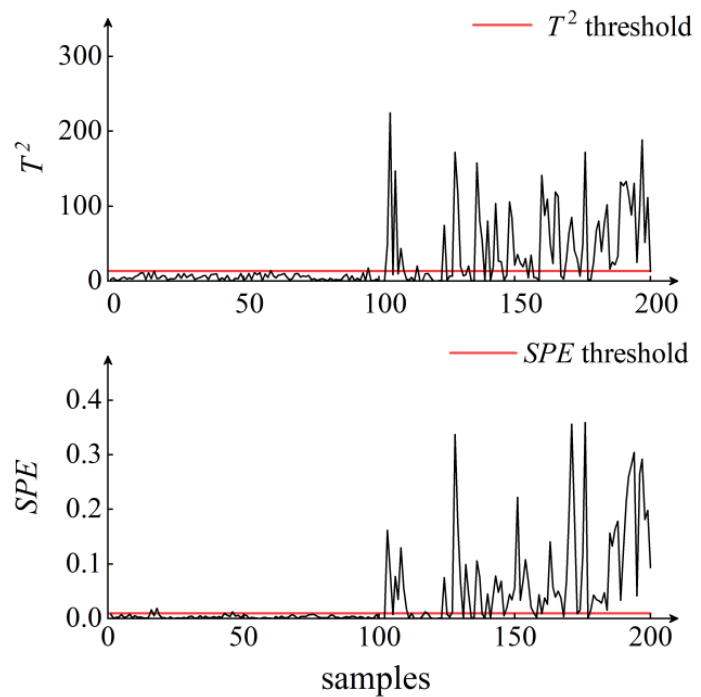
Figure 9. KPLS monitoring of sample 1.